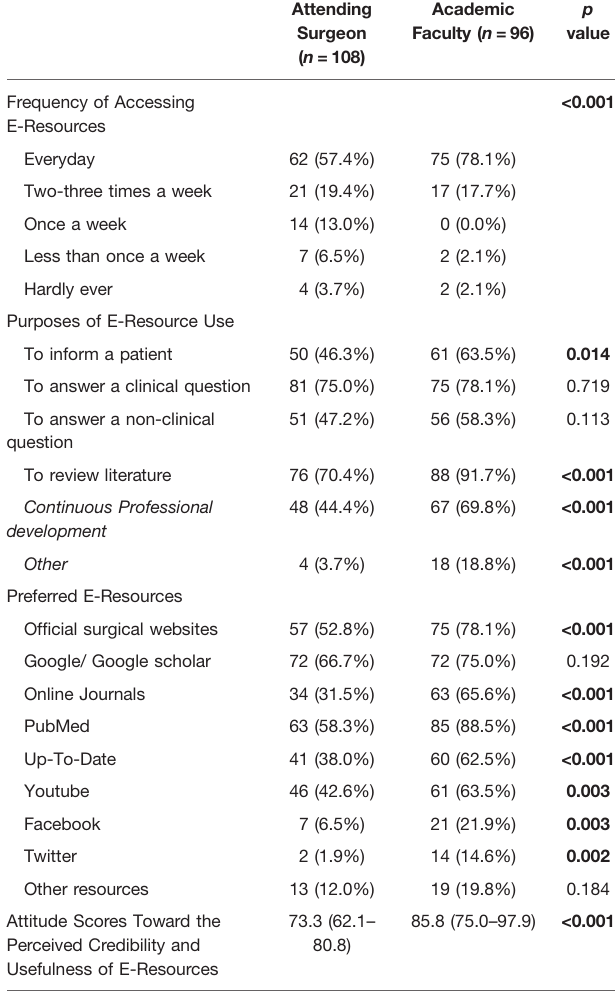
TABLE 4 | Comparison of academic and non-academic participants ’ attitude and use of online continuous professional development resources.